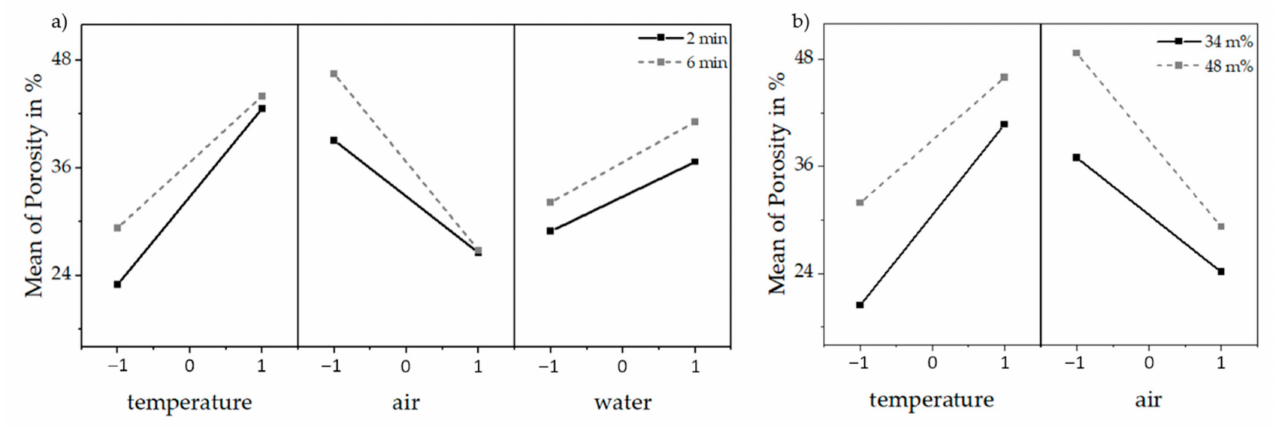
Figure 5. Two-way interaction effects as a function of P ( a ) and W ( b